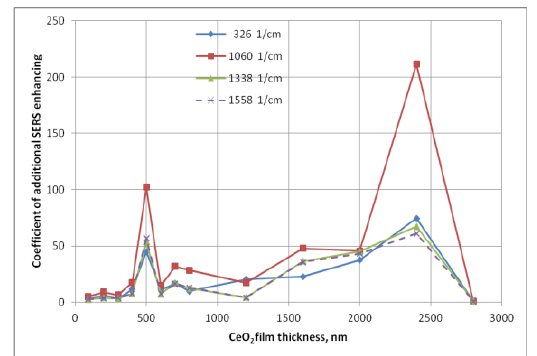
Figure 7: SERS signal at different Raman scattering bands from DTNB - Au-NP on cerium dioxide films with various thicknesses after normalization to the signal from films with a thickness of 2800